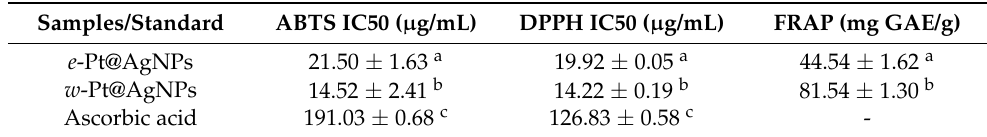
Table 2. FRAP value and IC 50 from the w -Pt@AgNPs, e -Pt@AgNPs, and Standard Drug.